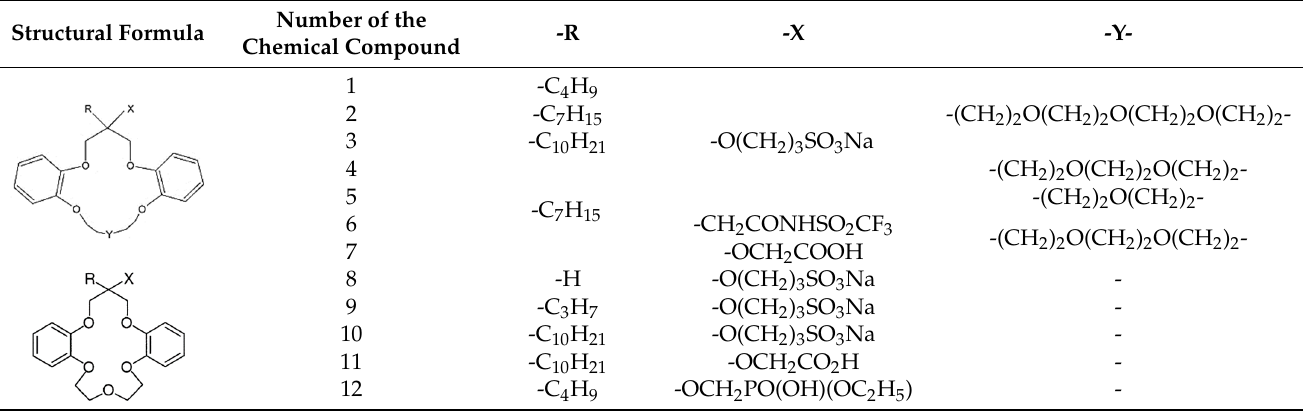
Table 1. Collectors used in Zn(II) and Cd(II) ion flotation process in the quoted works [22–26]. Number of the Chemical Structural Formula